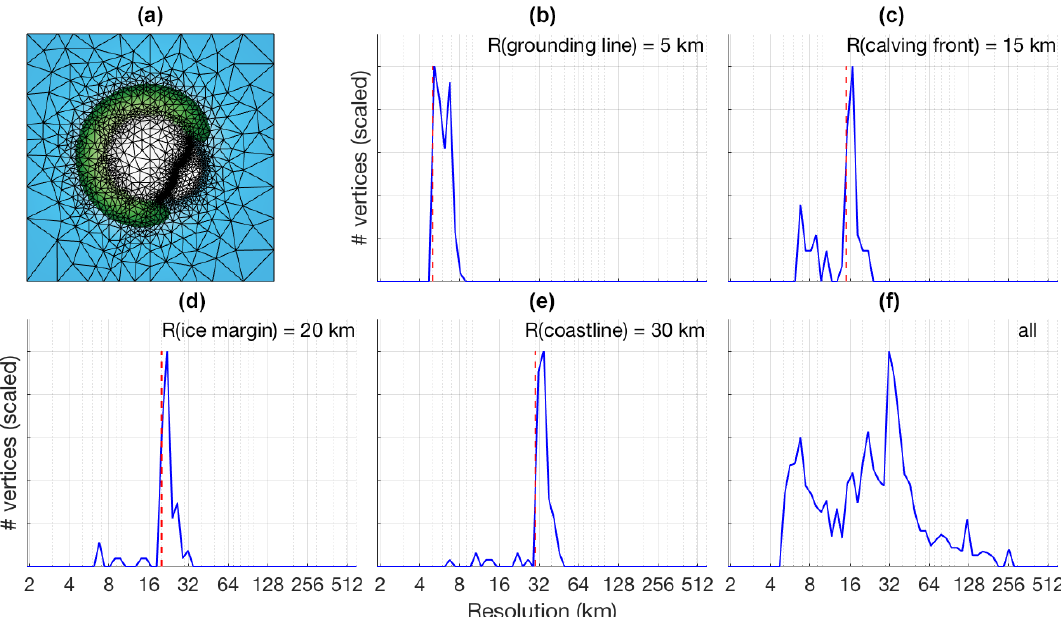
Figure E1. The results of a schematic experiment, where an ice sheet and shelf are simulated over a small island with an embayment on the south-east side. Blue indicates open ocean, green indicates ice-free land, white indicates ice. (b–f) Resolution distributions for, respectively, the grounding line, the calving front, the ice margin, the coastline, and the entire mesh. The resolutions that have been prescribed for these different regions are indicated by the vertical dashed red lines.